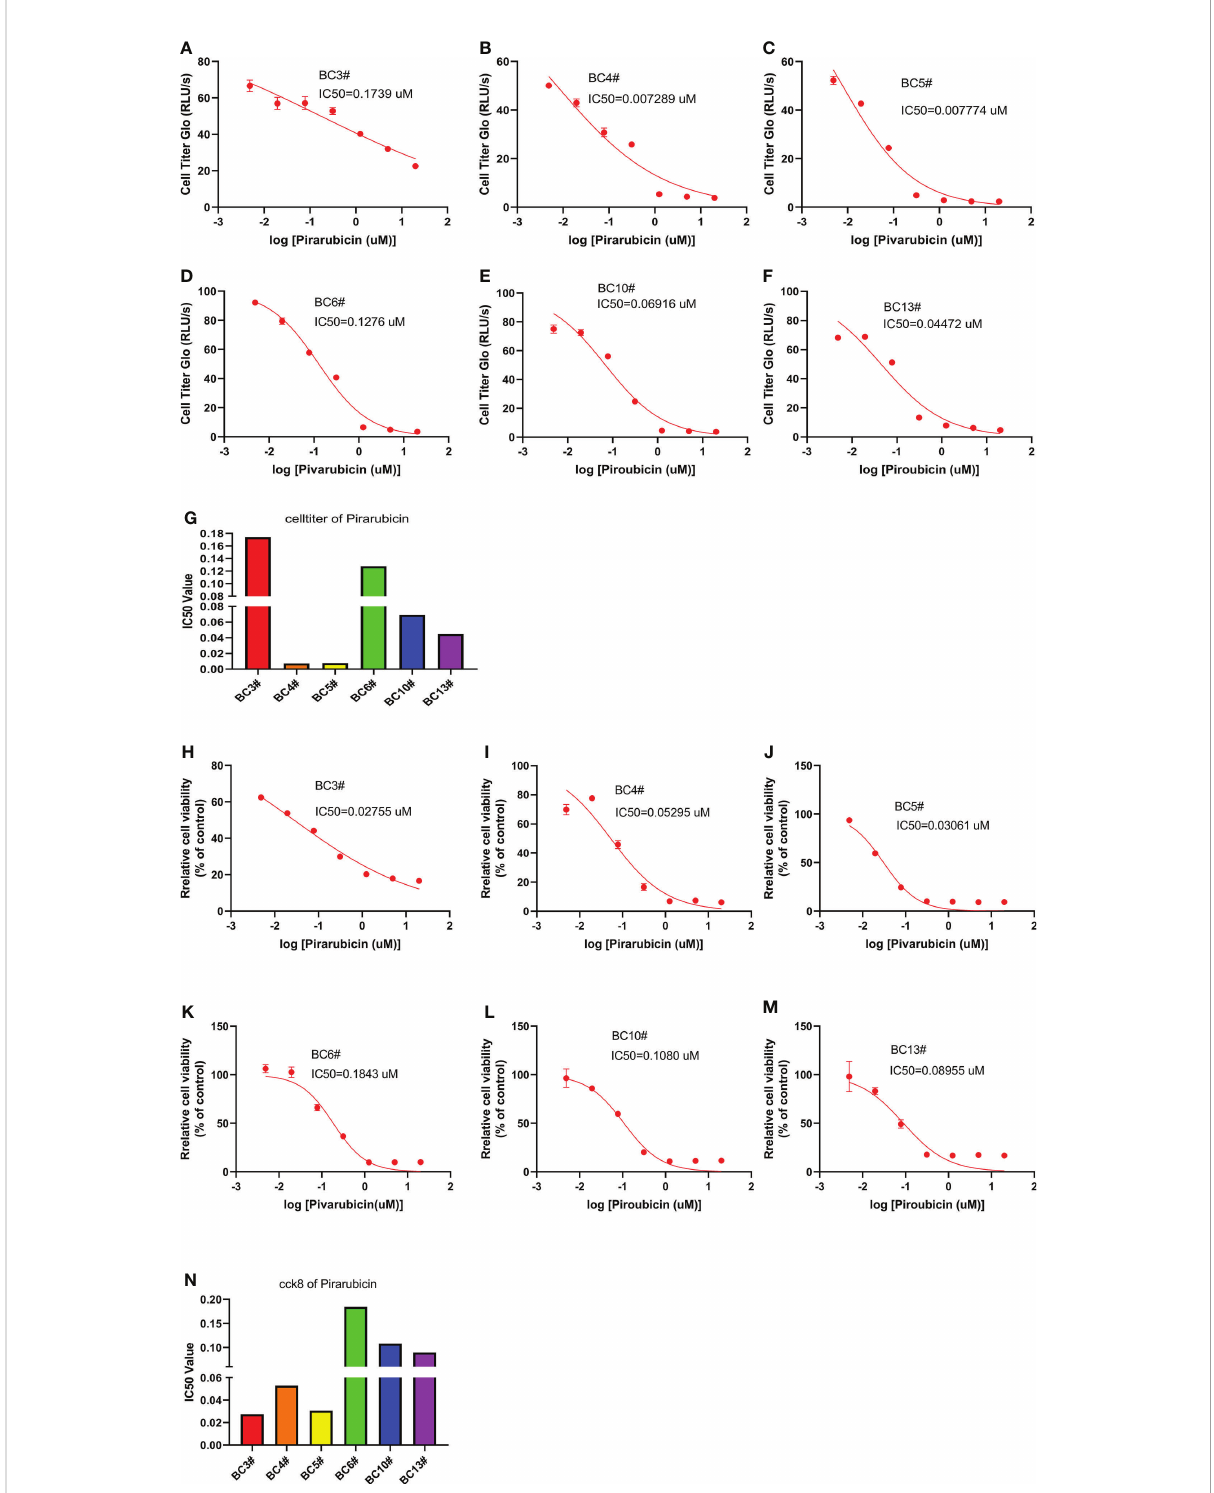
FIGURE 3 The killing assay of pirarubicin by the CellTiter-Glo and CCK8 assays. (A – G) The CellTiter-Glo assay to measure the IC 50 value of pirarubicin in the primary breast cancer cells BC3, BC4, BC5, BC6, BC10, and BC13. (H – N) The CCK8 assay to measure the IC 50 value of pirarubicin in the primary breast cancer cells BC3, BC4, BC5, BC6, BC10, and